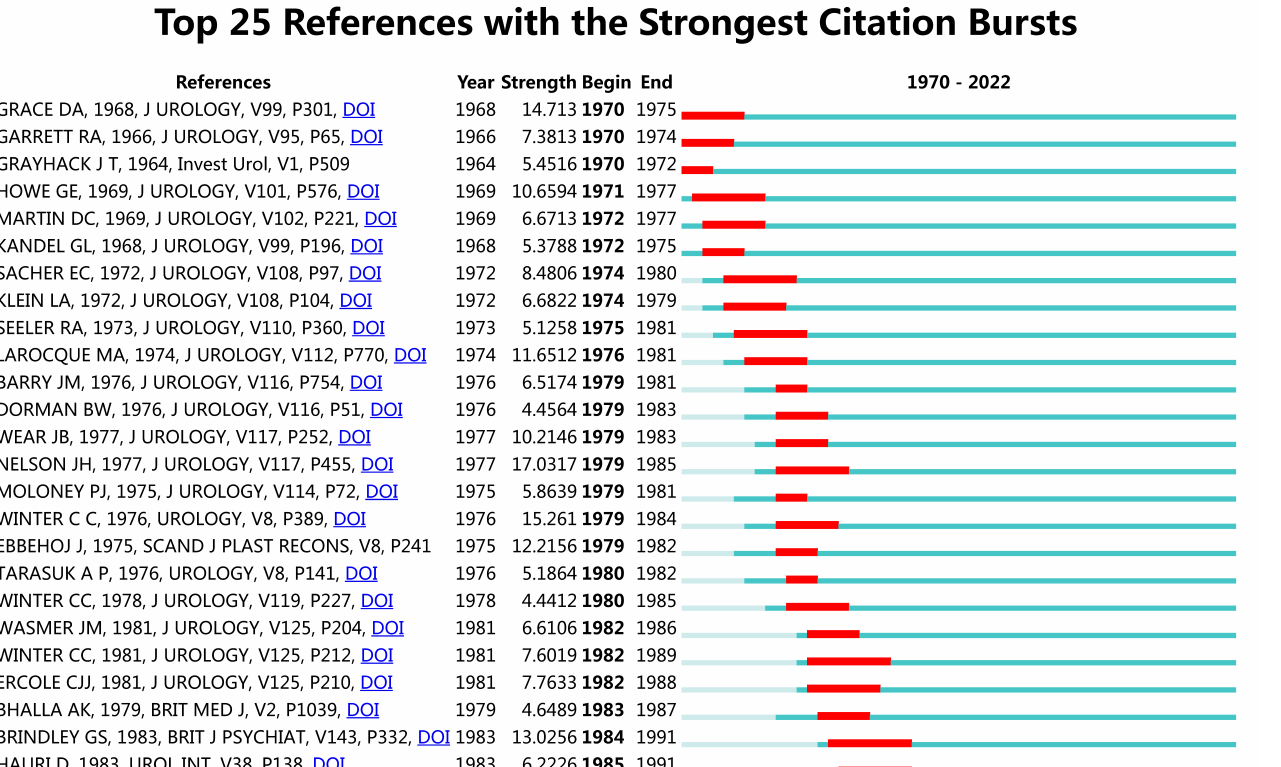
FIGURE 7. The top 25 references with the strongest citation bursts in the co-citation